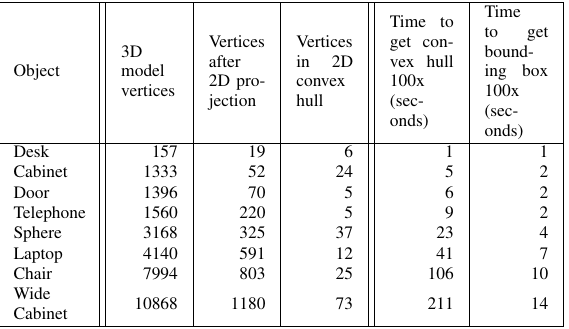
Figure 1: Overview of the spatial modalities framework. Table 1: Comparison of vertex count used to represent shapes in BIM, 2D projection, convex hulls, and time taken to parse an IFC STEP file and compute convex hulls and bounding boxes (repeated 100 times for each object).